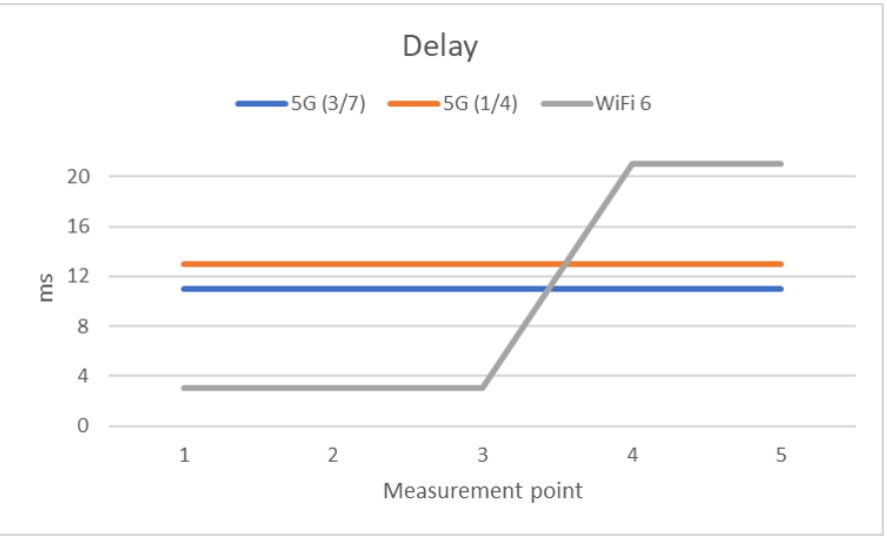
Figure 5. Average